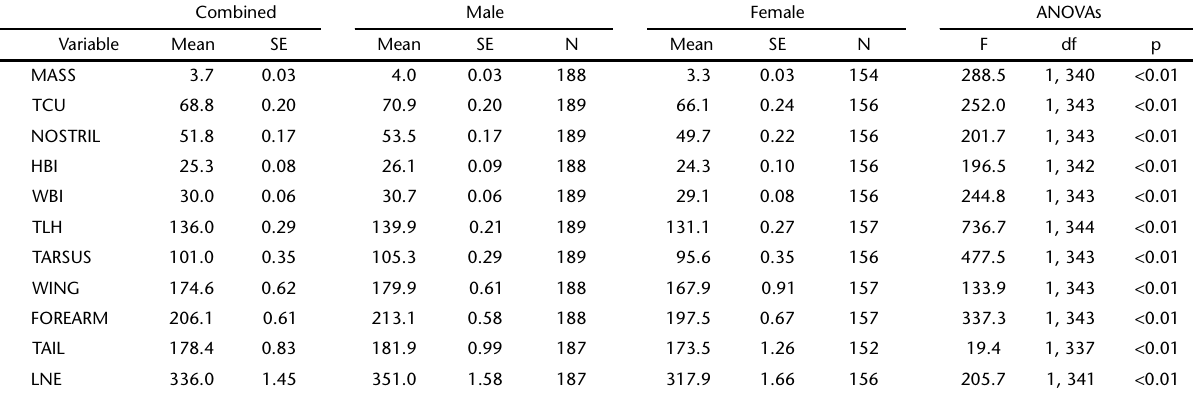
Table I. Means, standard errors and sample sizes for body mass (kg) plus ten morphometric variables (in mm) for the Coscoroba Swan according to sex. Results for univariate ANOVAs between sexes for each measurement are also shown.